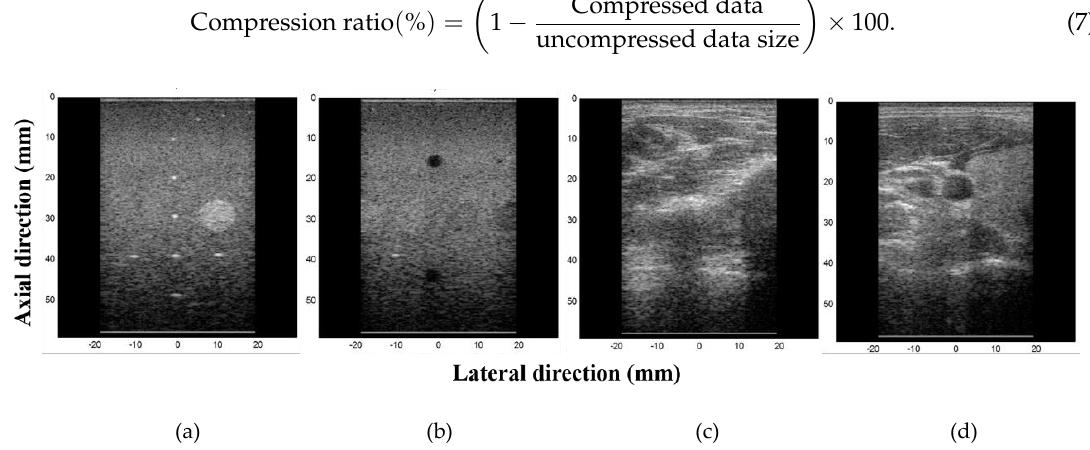
Figure 3. Ultrasound images showing ( a ) point targets, ( b ) cysts, ( c ) nerve and ( d ), which were constructed by utilizing the proposed BL code.